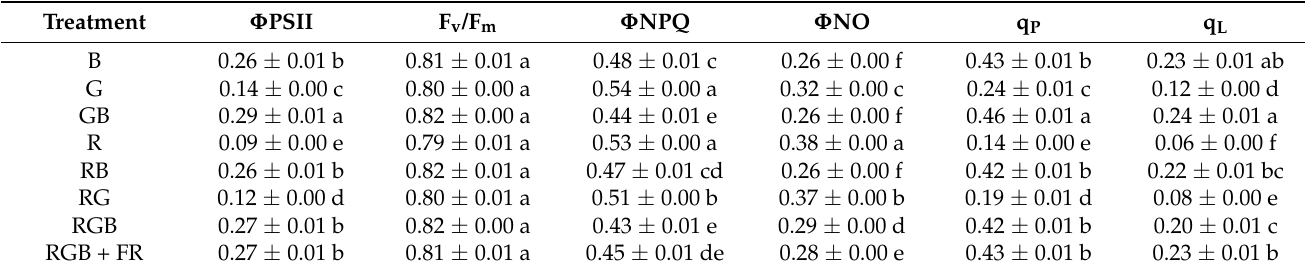
Table 2. Maximum quantum efficiency of PSII (Fv/Fm), relative PSII operating efficiency ( Φ PSII), coefficient of photochemi- cal quenching (qp), the quantum yield of non-light-induced nonphotochemical quenching ( Φ NPQ), the quantum yield of light-induced nonphotochemical quenching ( Φ NO), and the fraction of oxidized plastoquinone (q L ) calculated using measurements under saturating (1000 µ mol photons m − 2 s − 1 ) 90% red, 10% blue light. Different letters indicate significant differences ( p ≤ 0.05; n = 3 or